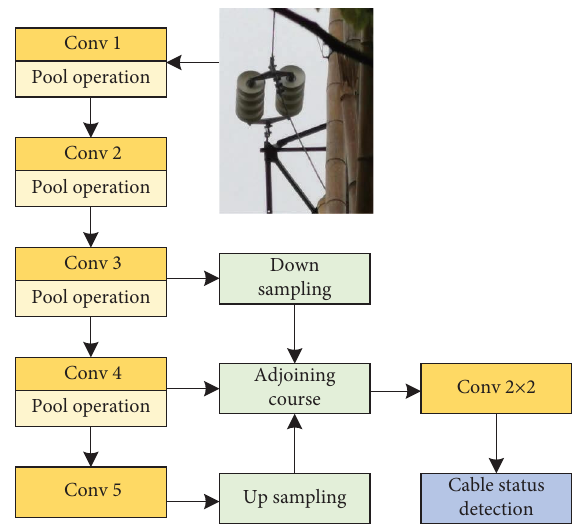
Figure 5: Frame diagram of the improved Faster-RCNN line part detection model.